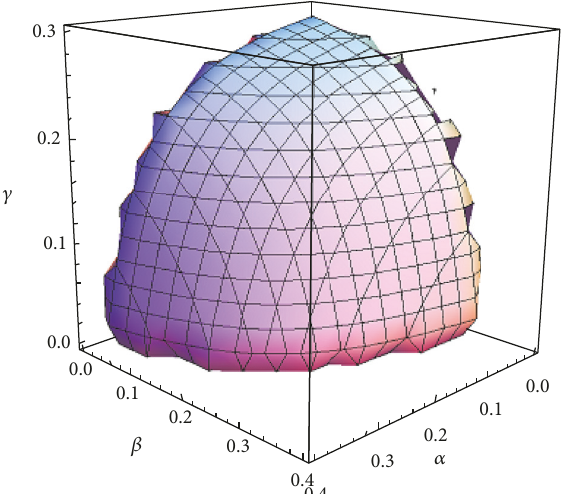
Figure 2: The stable region of Nash equilibrium point, (𝑒 1 ,𝑒 2 , 𝑒 3 ) = (1, 1.1, 1.2) .